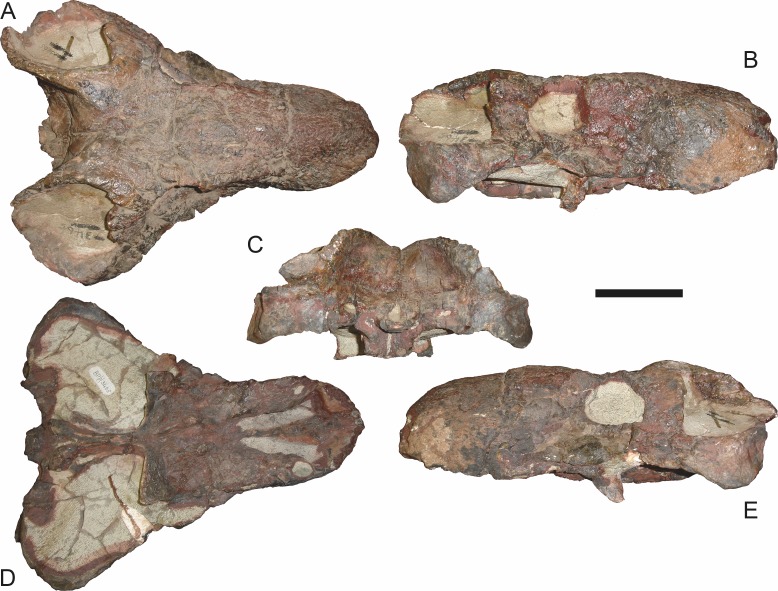
Referred specimen (BP/1/3465) of Sycosaurus laticeps
Haughton, 1924 in (A) dorsal, (B) right lateral, (C) occipital, (D) ventral, and (E) left lateral view.Scale bar equals 10 cm.